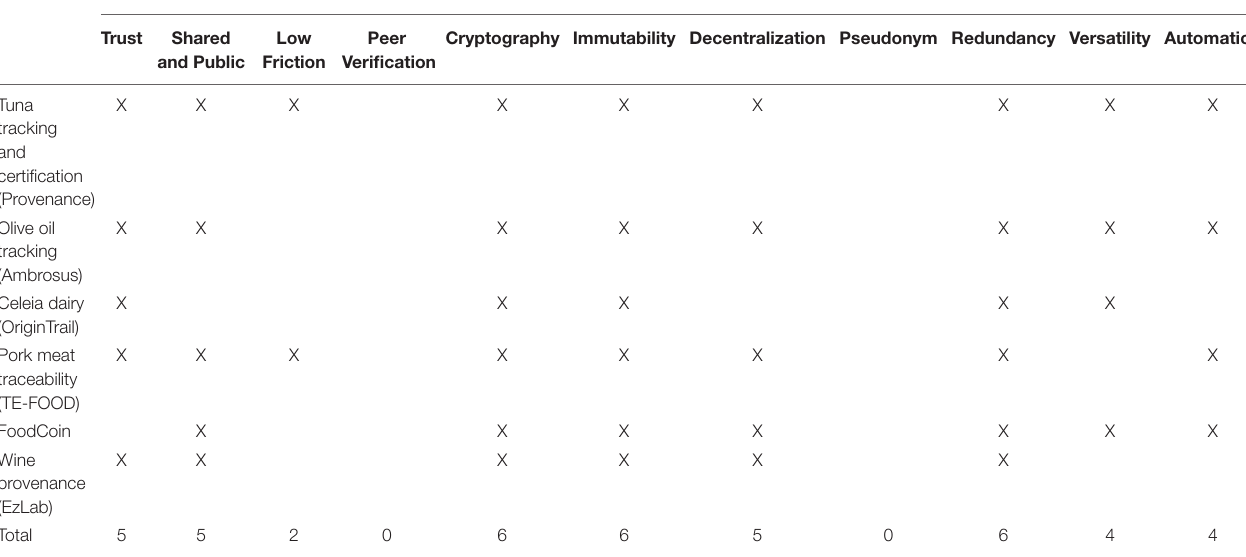
TABLE 4 | Company classification by the blockchain characteristics.